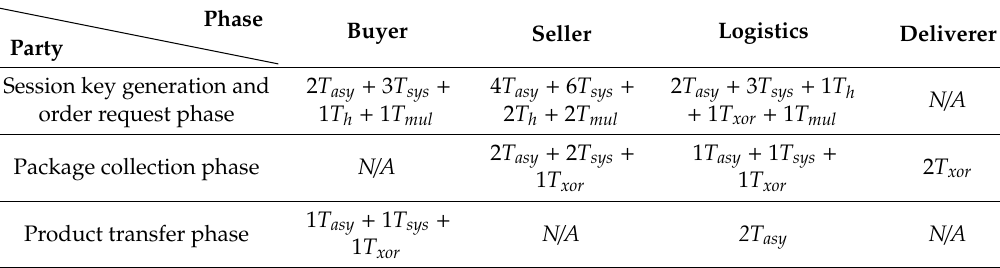
Table 2. Computation costs of the proposed